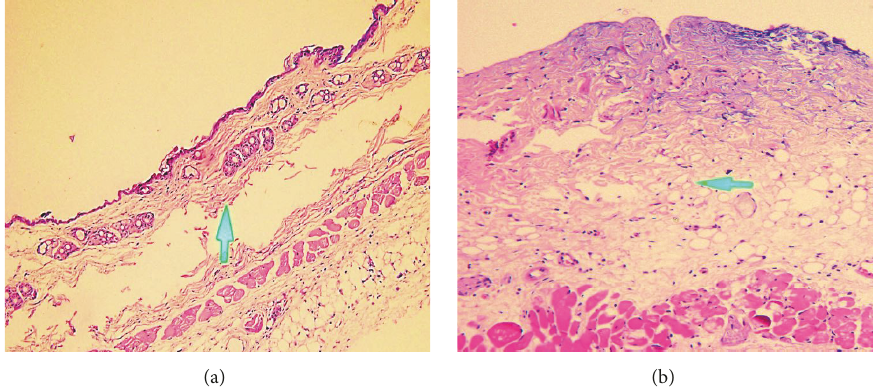
Figure 3: Establishment of second-degree burn wound models . Histological analysis showed that injury of burn wound was extended into both epidermis and dermis. In normal skin section, thick squamous epithelium covered the epidermis, and both of epidermis and dermis had the normal structure with several hair follicles and sebaceous glands (a). In burn wound skin section, epidermis and dermis lost their normal structure. Of note, squamous epithelium layer was removed, and epidermis was necrotized. Moreover, the underlying stromal tissue was swollen and congestive (b). These results indicated that the second-degree burn model was successfully established in experimental mice. The arrows indicated the border between the dermis and